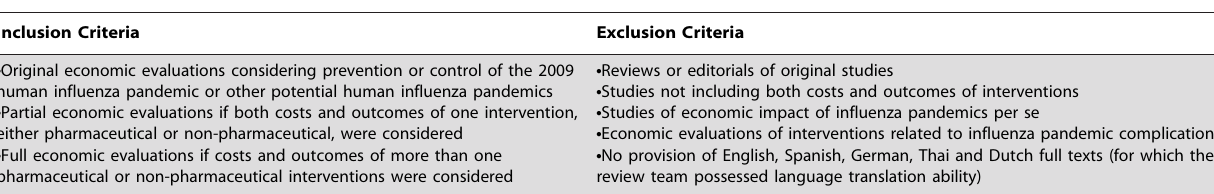
Table 1. Inclusion and exclusion criteria employed in the abstract selection process.